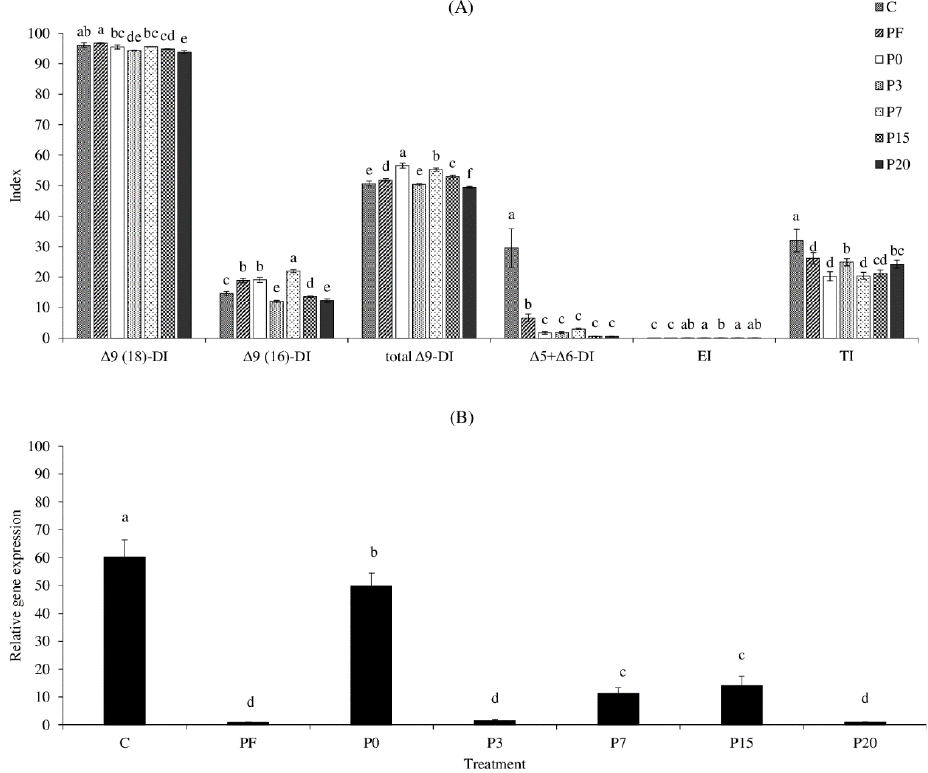
Figure 2. Comparison of fatty acid metabolism indices ( A ) and fads2 gene expression ( B ) of sago palm weevil larvae (SPWL) fed on different diets. Values are given as mean ± standard deviation from triplicate determinations. Different letters in the same attribute indicate significant differ- ences ( p < 0.05). Experimental diet nomenclature: C: control, PF: diet supplemented with pig feed, P0-P20: diets contained 0–20% perilla seed, respectively. DI = desaturase index, EI = elongase index, TI = thioesterase